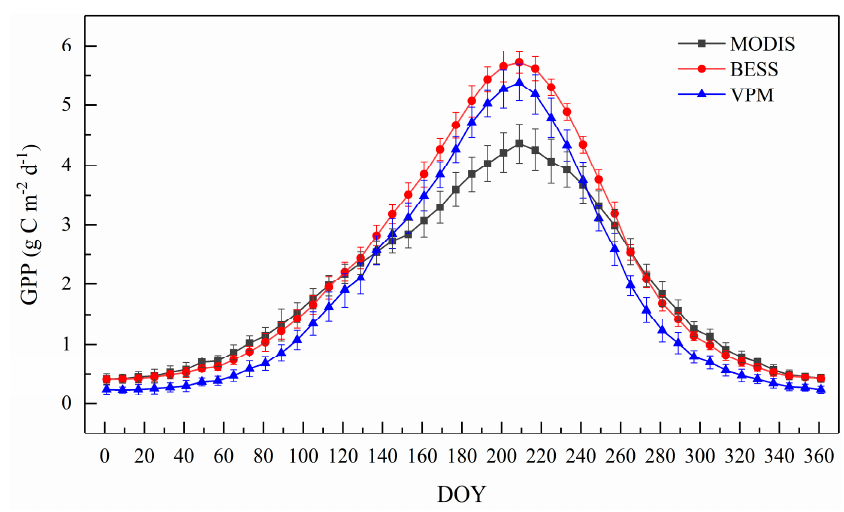
Figure 4. Seasonal dynamics of multiyear average MODIS GPP, BESS GPP, and vegetation photosynthesis model (VPM) GPP at an 8-day interval from 2001 to 2015 across China. DOY represents “day of the year”. The error bars mean the standard error.